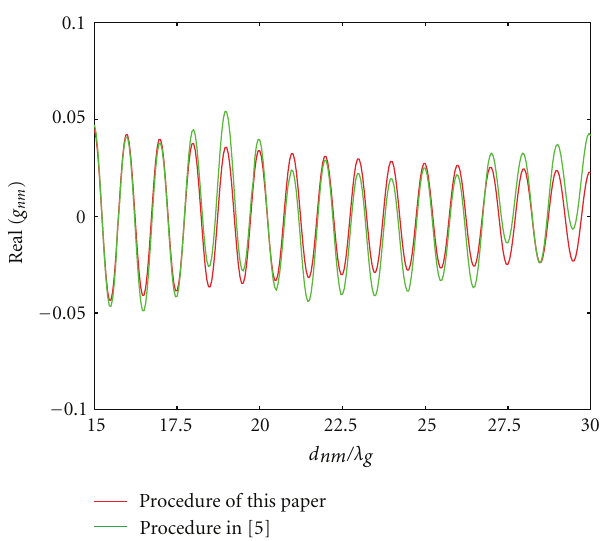
Figure 8: Real part of the mutual coupling coe ffi cient g nm , θ = 90 ◦ . The results for d nm < 15 λ g are not shown since the curves virtually overlap.